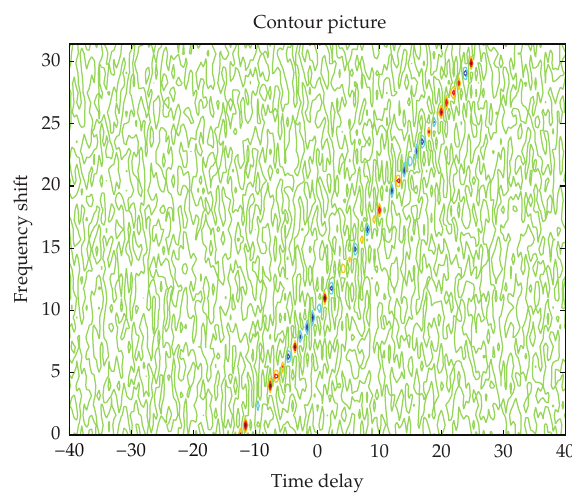
Figure 5: The contour of WVD of f (cid:4) t (cid:5) with SNR (cid:7) 5dB.